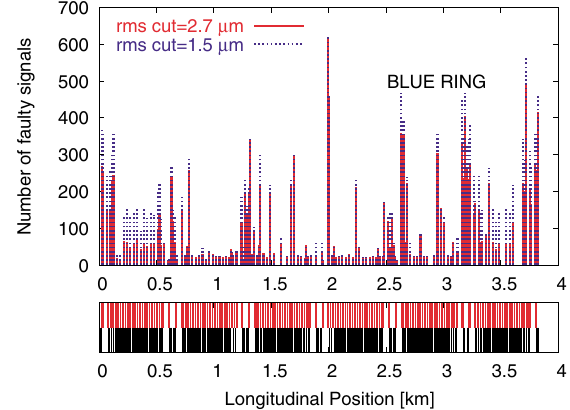
FIG. 7. (Color) Comparison between two different rms cuts showing qualitatively similar results.